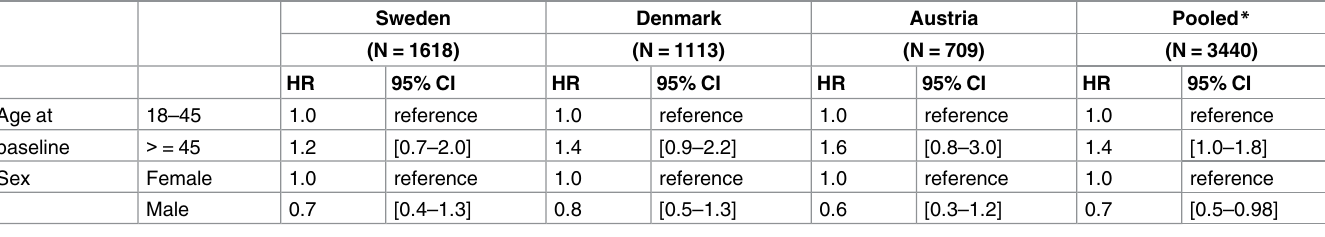
Table 4. Adjusted hazard ratios for risk factors of anti-natalizumab ADA